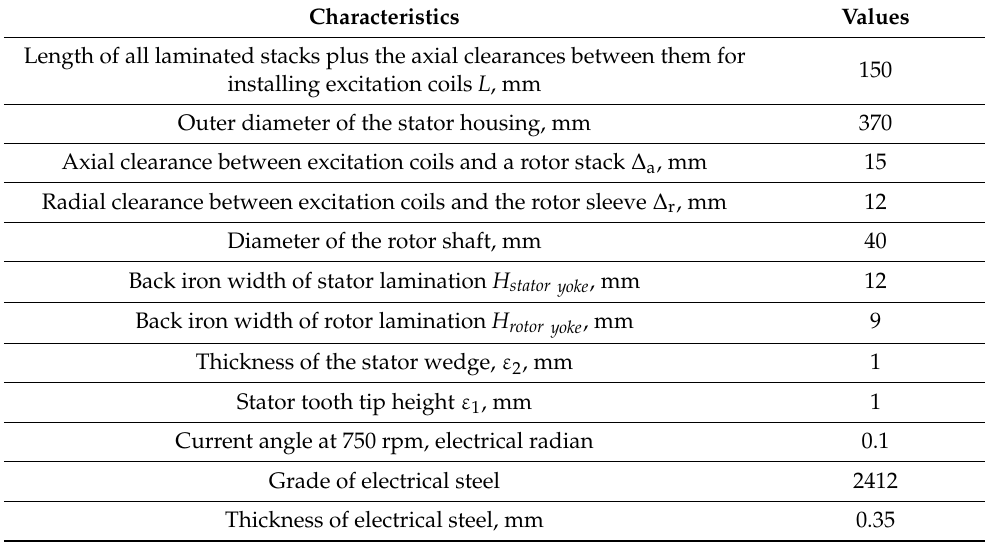
Table 1. Main unchangeable parameters of the generator. Characteristics Values